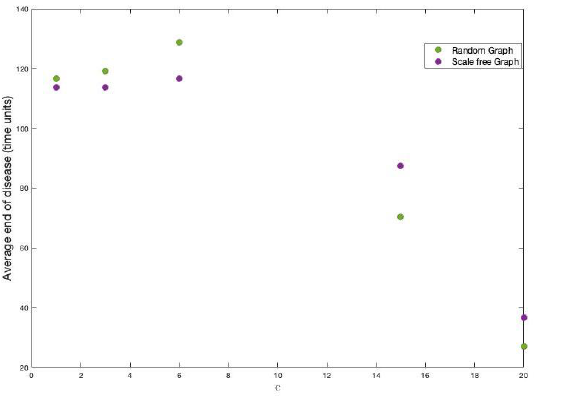
Figure 17. Average end of disease for different c in random and scale-free